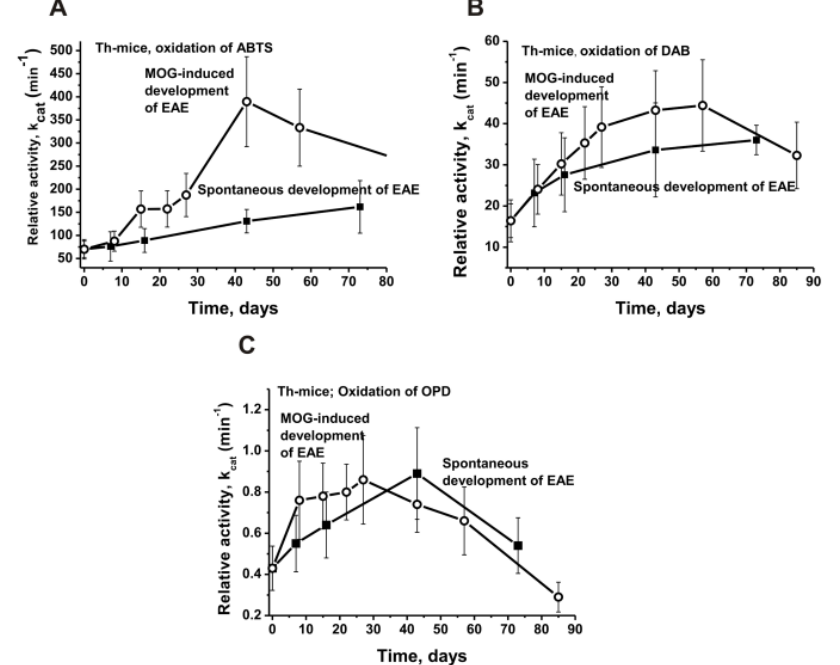
Figure 3. Average changes over time in the relative activity in the oxidation of ABTS ( A ), DAB ( B ), and OPD ( C ) before and after Th mice immunization with MOG. Spontaneous development of EAE corresponds to untreated mice. All of the designations are marked in three panels. The mean values of k cat corresponding to 10 mice of each group are presented.